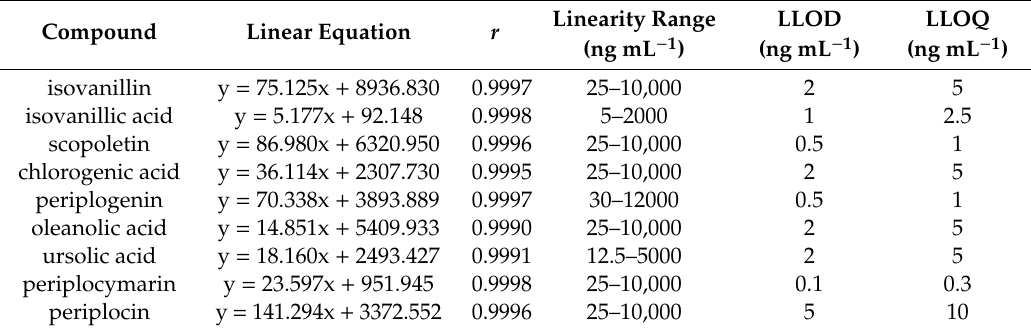
Table 2. Standard curve regression equation, lower limit of detection (LLOD), and lower limit of quantification (LLOQ) of nine components.